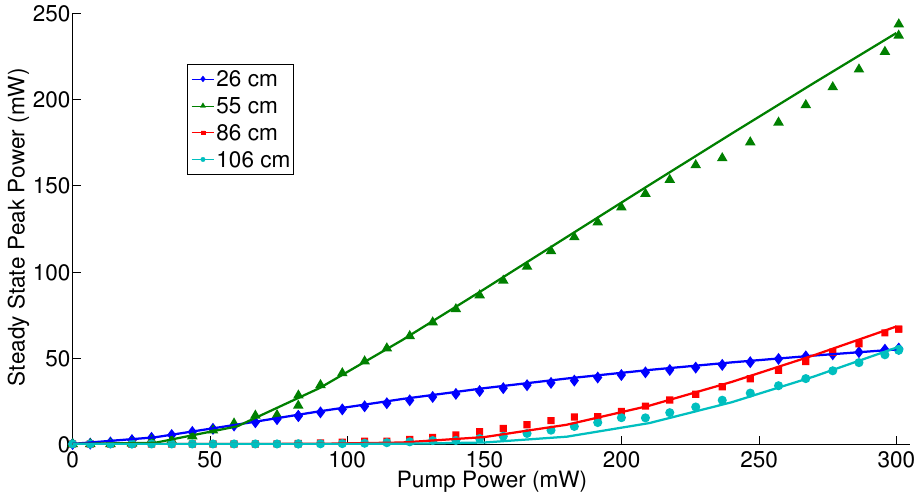
Figure 15. The measured steady state peak power plotted with the simulated steady state peak power, using parameter values in Table 5, with four fiber lengths: 26 cm, 55 cm, 86 cm, and 106 cm. The data markers are the experimental measurements from the FLAT characterization experiment while the curves are from the simulation.